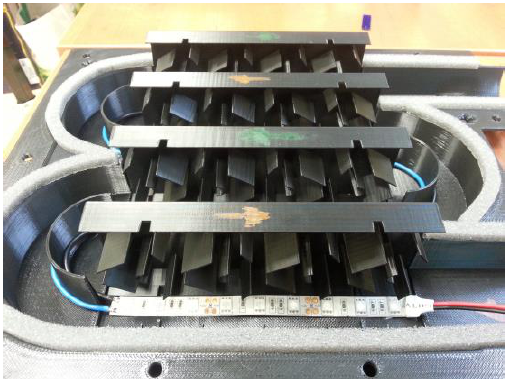
Fig. 2. Photocatalytic reactor used in the experiment